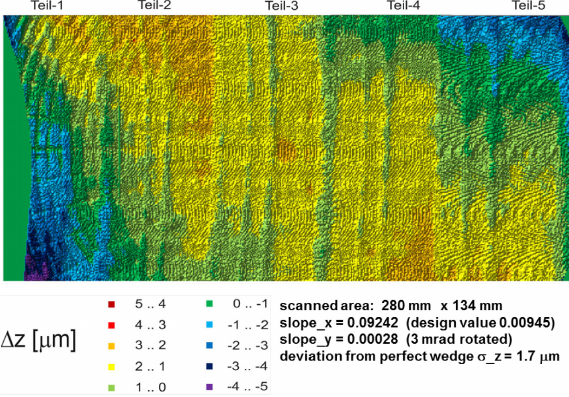
Fig. 9. Assembled and fitted data of thickness [4] of the degrader disk coming from the overlapping measurement areas measurements T1 – T5 as shown in